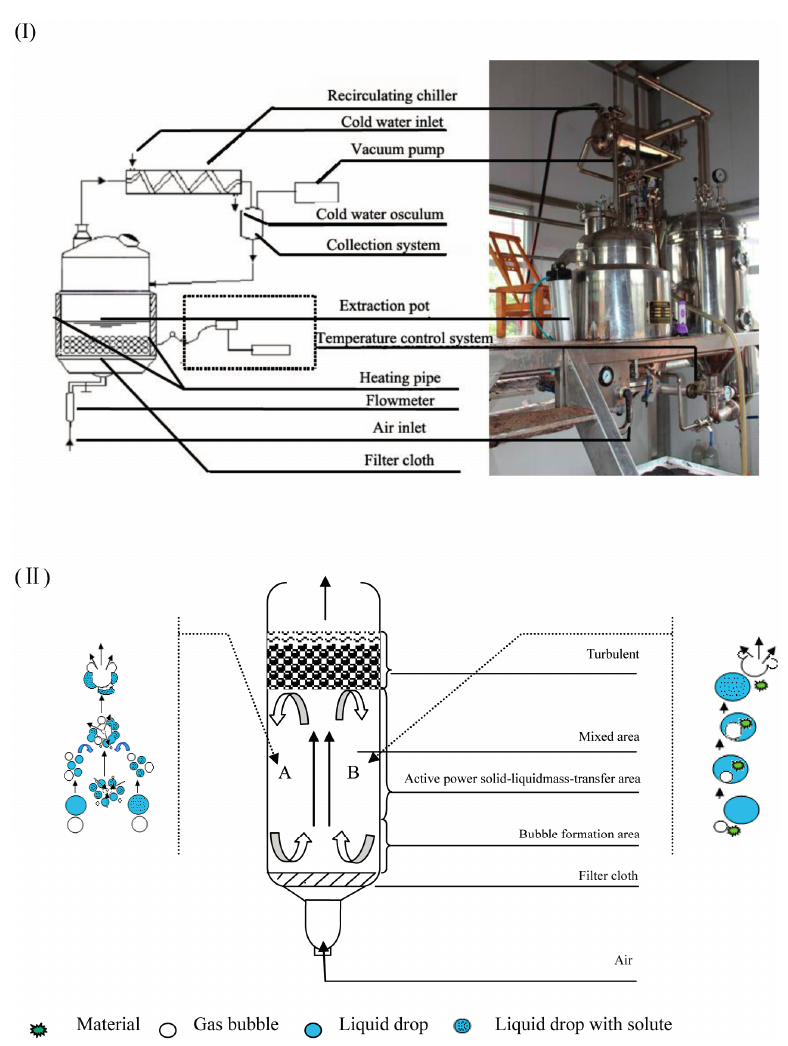
Figure 3. ( I ) Schematic diagram of the NPCE device; ( II ) the sketch map for the basic mechanism of the mass-transfer between liquid-liquid (A) and liquid-solid system